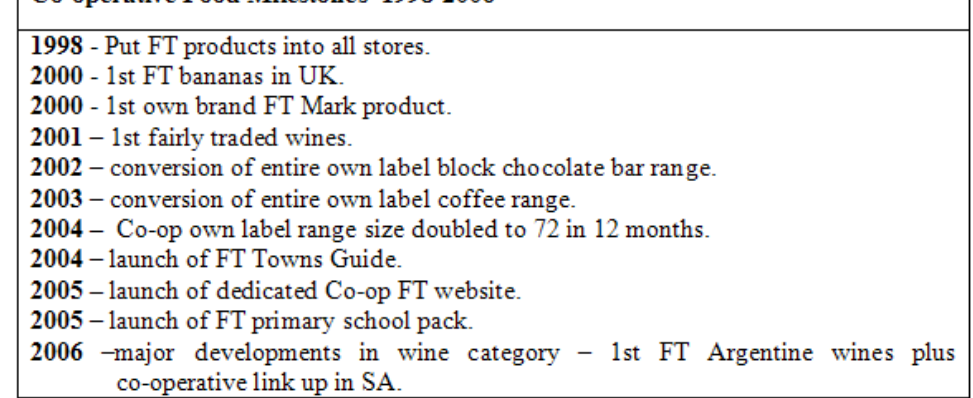
Table 1: Co-operative Food Fairtrade